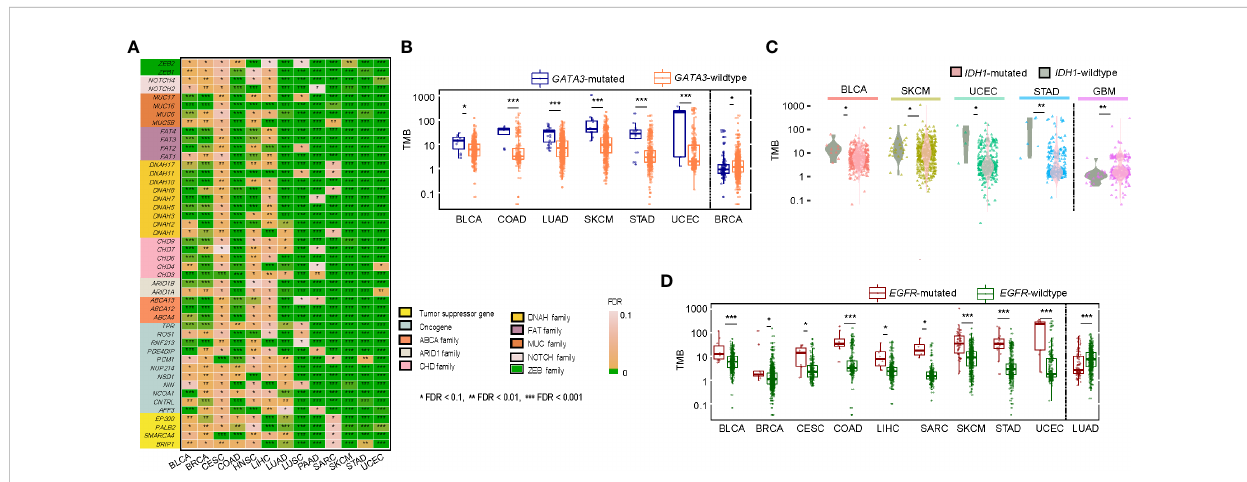
FIGURE 2 Correlations of gene mutations with TMB. (A) A list of tumor suppressor genes, oncogenes, and gene families whose mutations were signi fi cantly associated with increased TMB in at least ten cancer types. Comparisons of TMB between GATA3 -mutated and GATA3 -wildtype (B) , between IDH1 - mutated and IDH -wildtype (C) , and between EGFR -mutated and EGFR -wildtype cancers (D) . The one-tailed Mann-Whitney U test adjusted P -values (FDR) are